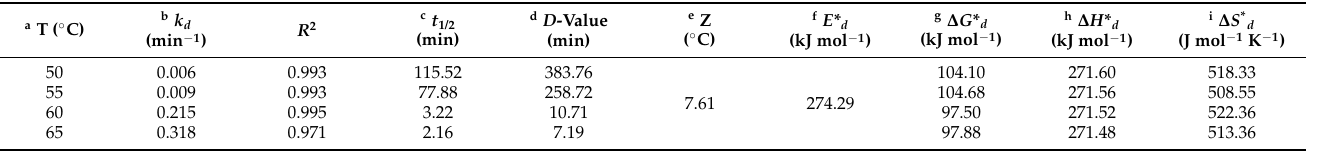
Figure 4. Semi-log plots of thermal denaturation of FFase from A. tamarii Kita UCP 1279 performed at pH 5.0 and using an initial substrate (sucrose) concentration of 60% ( w v − 1 ). Table 2. Kinetic and thermodynamic parameters for thermal denaturation of FFase from Aspergillus tamarii Kita UCP 1279.